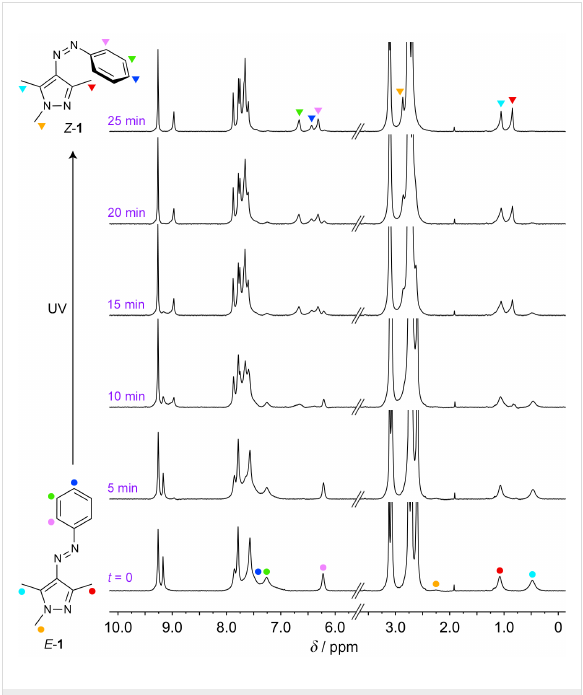
Figure 6: A series of 1 H NMR spectra of ( E - 1 ) 2 2 (500 MHz, D 2 O, 298 K) before (bottom) and after exposure to UV light ( λ = 365 nm) inside the NMR spectrometer (using an optical fiber) for different periods of time (indicated in purple font) for up to 25